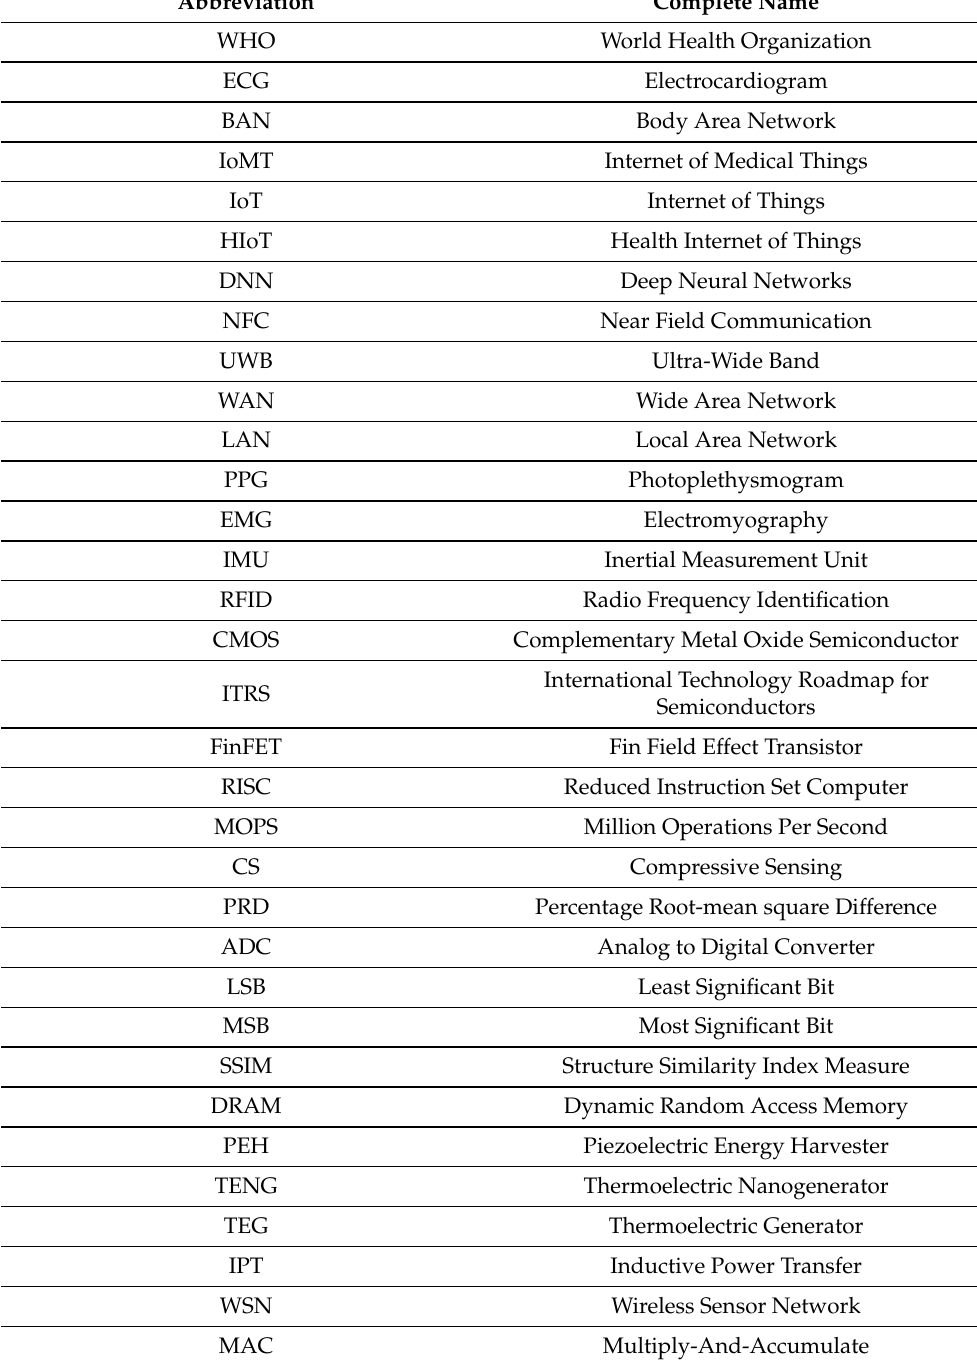
Table 1. List of